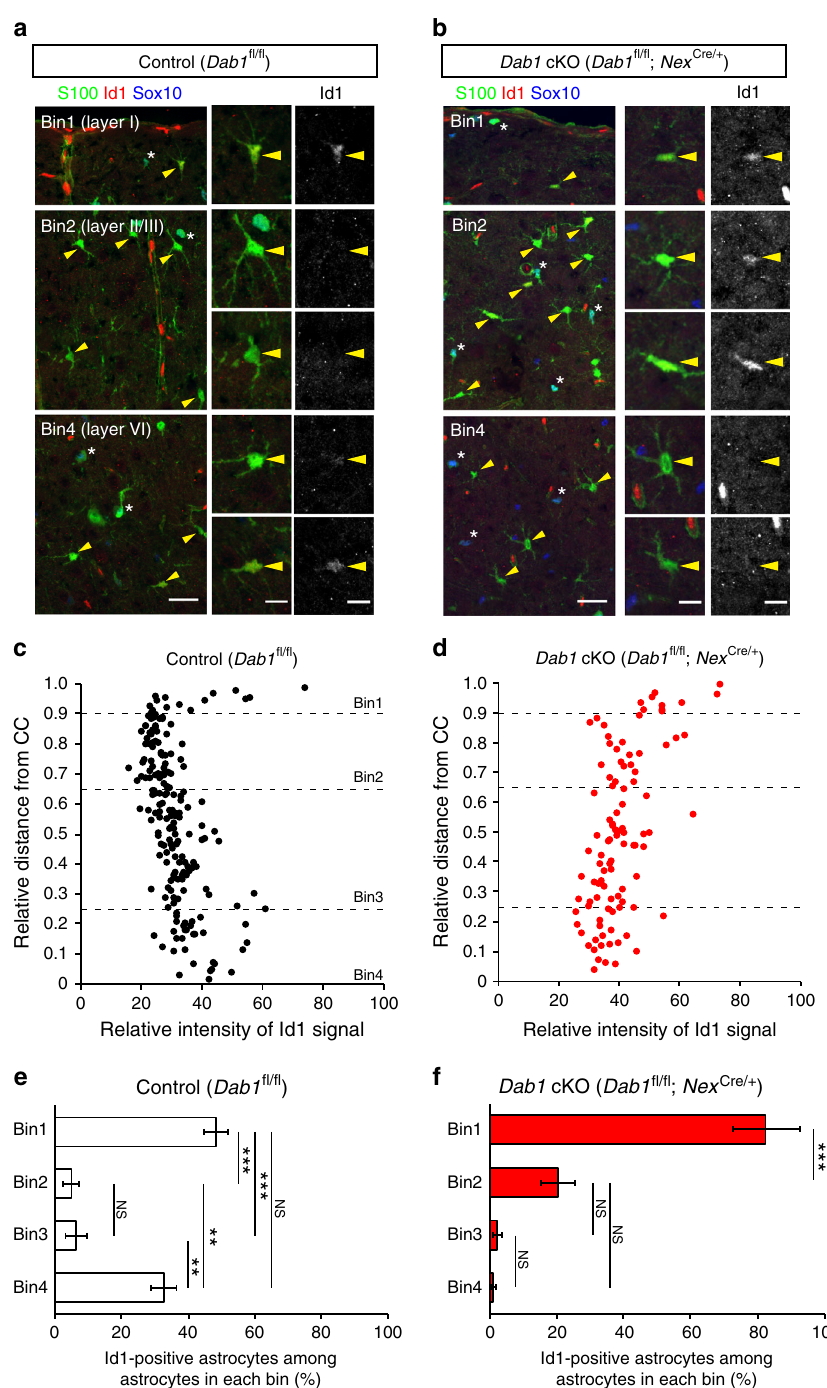
Fig. 6 Layer-speci fi c expression of Id1 in neocortical astrocytes and its disruption in Dab1 cKO mice. a , b Immuno fl uorescence staining for S100, Sox10, and Id1 in coronal sections of control ( Dab1 fl / fl ) ( a ) and Dab1 cKO ( Dab1 fl / fl ; Nex Cre/ + ) ( b ) mice at P30. Astrocytes were identi fi ed as S100-positive, Sox10- negative cells (arrowheads); asterisks indicate double-positive cells. Individual astrocytes and Id1 signals are shown in the right panels at higher magni fi cation. Scale bars, 25 µ m (left panels) and 10 μ m (right panels). c , d Representative data of Id1 signal intensities in the nucleus of individual astrocytes in a coronal section from a control ( c ) and a Dab1 cKO ( d ) mouse. Astrocyte position in the cortical layers is expressed as relative distance from the corpus callosum (CC) to the pia, with dashed lines indicating the boundaries between bins: bin1, 0.9 – 1.0; bin2, 0.65 – 0.9; bin3, 0.25 – 0.65; and bin4, 0 – 0.25. e , f Percentage of Id1-positive astrocytes among total astrocytes in each bin of the neocortex of control ( e ) and Dab1 cKO ( f ) mice ( n = 3 mice). Perivascular astrocytes are excluded from quanti fi cation. Data are means ± s.e.m. from three mice of each genotype. ** P < 0.01; NS, not signi fi